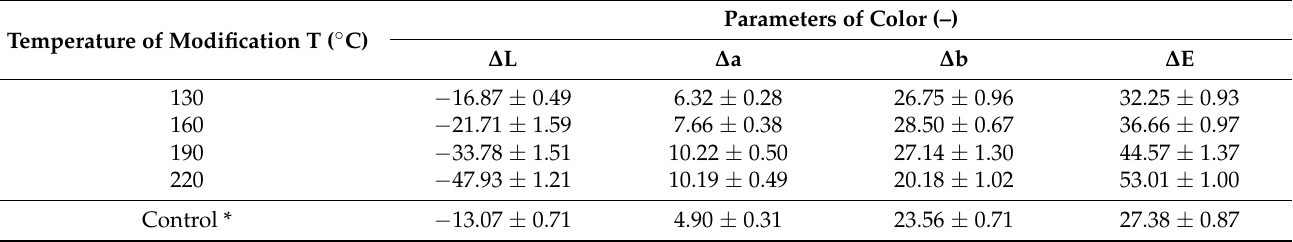
Table 1. Parameters of color change in modified wood at different temperature and at constant time.